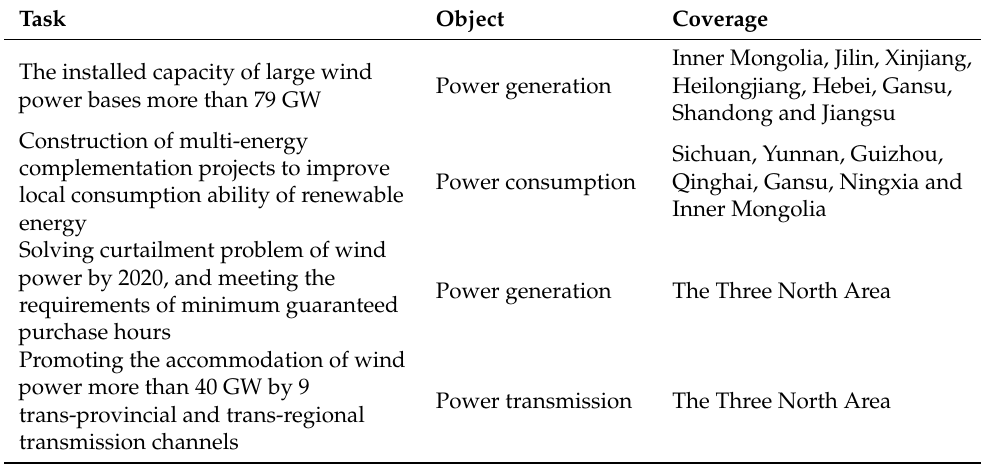
Table 5. Key tasks of wind power in